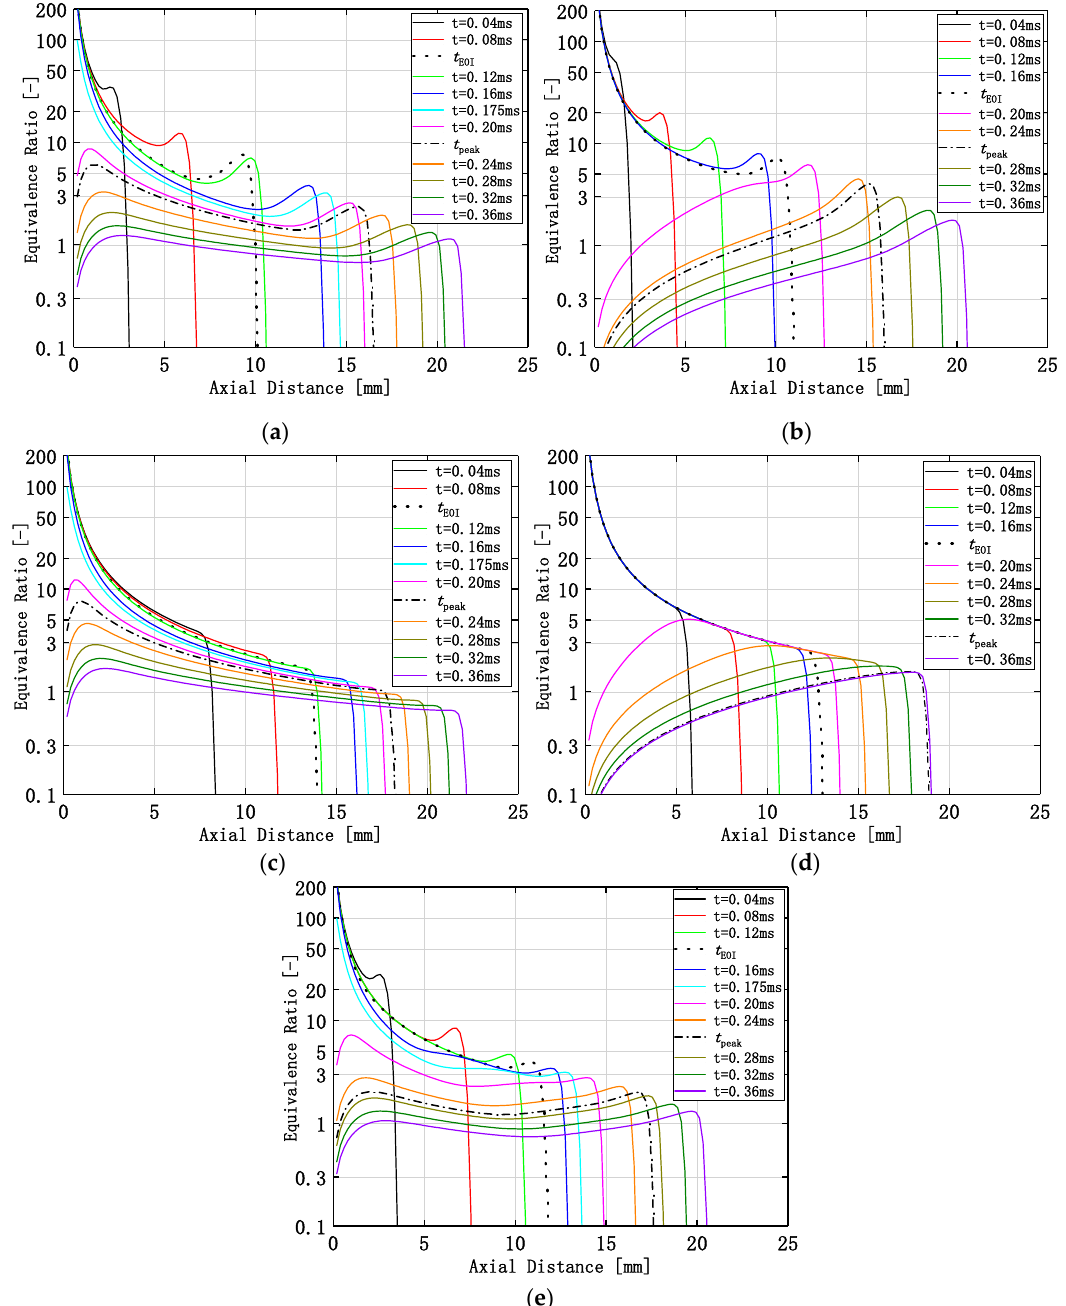
Figure 8. Equivalence ratio after EOI under five injection rate shapes: ( a ) Triangle; ( b ) Ramping-up; ( c ) Ramping-down; ( d ) Rectangle; ( e ) Trapezoid.